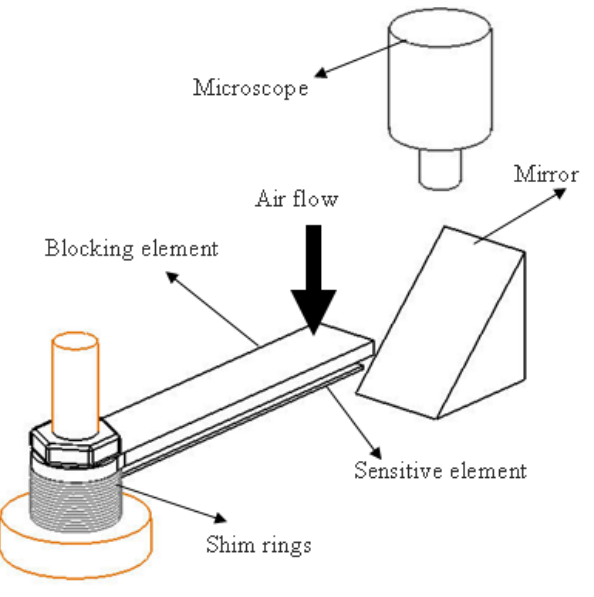
Figure 1. The experimental schematic for dynamic pressure sensing [8].